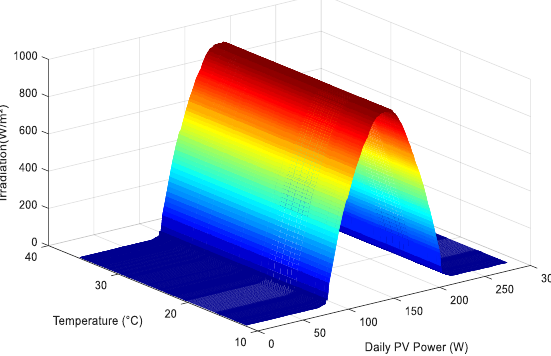
Figure 4. Typical 1-day PV power generation versus the temperature and